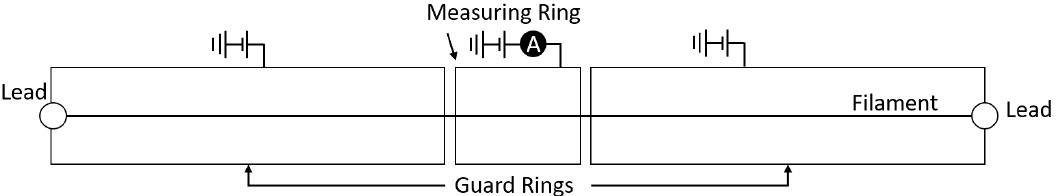
Figure 8. A scheme for how guard rings and the measurement conductor would be arranged. All three conductors would be biased at the same voltage and have the same shape. Around the center of the filament, the temperature can be considered almost constant. This means that, instead of a flattened curve, we would measure the same curve Taylor and Langmuir predict. Cylinders attached to the base are made of ceramic/insulating material, but all other elements are metal. It is paramount that the setup is structurally rigid to avoid shorts from small mechanical